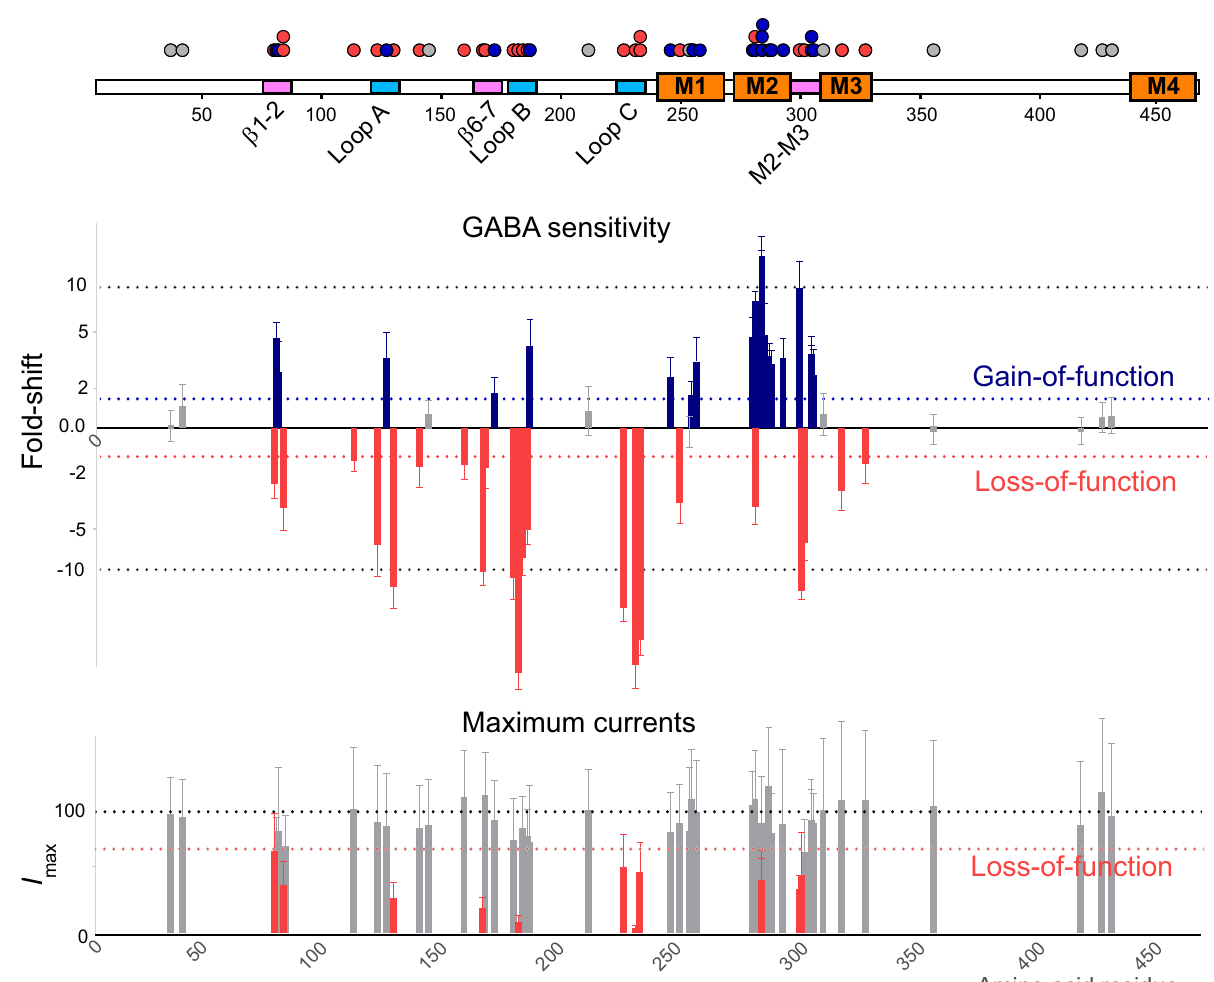
Fig. 3 Changes in GABA sensitivity and maximum currents of GABRB3 missense variants. A two-dimensional representation (top) of a GABA A receptor β 3 subunit depicting binding loops (blue), coupling loops (pink) and four transmembrane regions (orange) is shown. Bar graph summarizing the fold-shift in GABA sensitivity (mean Δ logEC 50 ± s.d.) and maximum current (mean I max ± s.d.) for each variant according to their amino acid residue. At GABA sensitivity, blue bars indicate variants that have signi fi cantly increased the GABA sensitivity with the direction of the bars upwards, red bars indicate variants that have signi fi cantly decreased the GABA sensitivity with the direction of the bars downwards and grey bars indicate no signi fi cant change. Signi fi cance was determined by one-way ANOVA ( F (53, 725) = 355.5) and multiple comparisons with corrected Dunnett ’ s post-hoc test ( p < 0.0001, n = 135 independent cells (wild-type); 10 (G32R, M80T, R142L, A305T, A305V, I306T); 11 (E77K, M80K, D120N, T157M, Y182F, Y184H, Q249K, S254F, L256Q, T281I, L284M, T287I, T288N, L293H, P301L); 12 (S76C, V78F, L124F, L170R, E180G, F225C, Y230H, Y245H, P253L, I280F, L284R, L284P, Y302C, F318S, N328D, E357K, S420I, R429Q, S433L); 13 (E178G, T185I); 14 (K127R, L165Q, Q210H, R232Q, T281A); 15 (V37G, N110D, ins138_139H, R166S, I300T); 17 (L310I). At maximum current, grey bars indicate no signi fi cant change and red bars indicate signi fi cantly reduced maximum currents. Signi fi cance was determined by one-way Kruskal – Willis ANOVA (H(55, 1653) = 674.4) and multiple comparisons with corrected Dunn ’ s post-hoc test ( p < 0.0001, n = 256 independent cells (wild-type); 22 (R232P, L284R, I300T, Y302); 23 (D120N, L124F, L284, P301L, A305T); 24 (E77K, V78F, M80K, K127R, L165Q, Q210H, R232Q, Y245H, P253L, S254F, L256Q, I280F, T281A, T281I, L284M, T287I, T288N, L293H, A305V, I306T); 26 (M80T, Y184H, Q249K); 27 (G32R, S76C, R142L, L170R, E180G, Y182F); 28 (L310I); 29 (F318S, E357K, R429Q, S433L); 30 (ins138_139H, Q210H); 33 (V37G), p.(R166S); 36 (S420Ile); 39 (N328D). Individual data points are in the supplementary information (Supplementary Fig S2). Source data are provided in the Source Data fi Behavioural abnormalities . There were no signi fi cant differences in the behavioural abnormalities reported in the GOF compared to the LOF cohort (6/9 cf. 27/36; OR = 0.19 [CI 0.15 – 2.9] Fisher ’ s exact test p = 0.6818). Abnormalities reported in the LOF cohort included autism spectrum disorder (6/36), autistic features (8/36) and ADHD (8/36) (Supplementary Fig. S11 and Tables S4, 5).